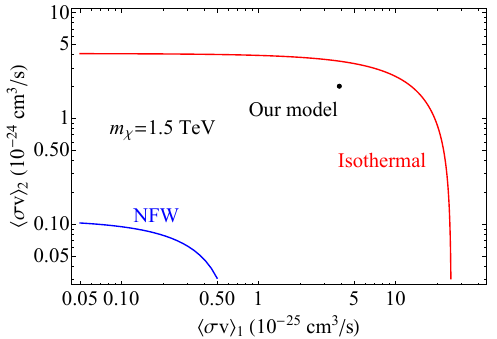
Figure 7 . HESS constraints on both annihilation channels. h (cid:27)v i 1 is the DM annihilation cross section mediated by the V 1 boson that kinetically mixes with the SM hypercharge; h (cid:27)v i 2 is the DM annihilation cross section mediated by the V 2 boson that is L (cid:22) (cid:0) L (cid:28) gauged. Here m (cid:31) = 1 : 5 TeV. The model point used in (cid:12)gure 4 is indicated by the black point